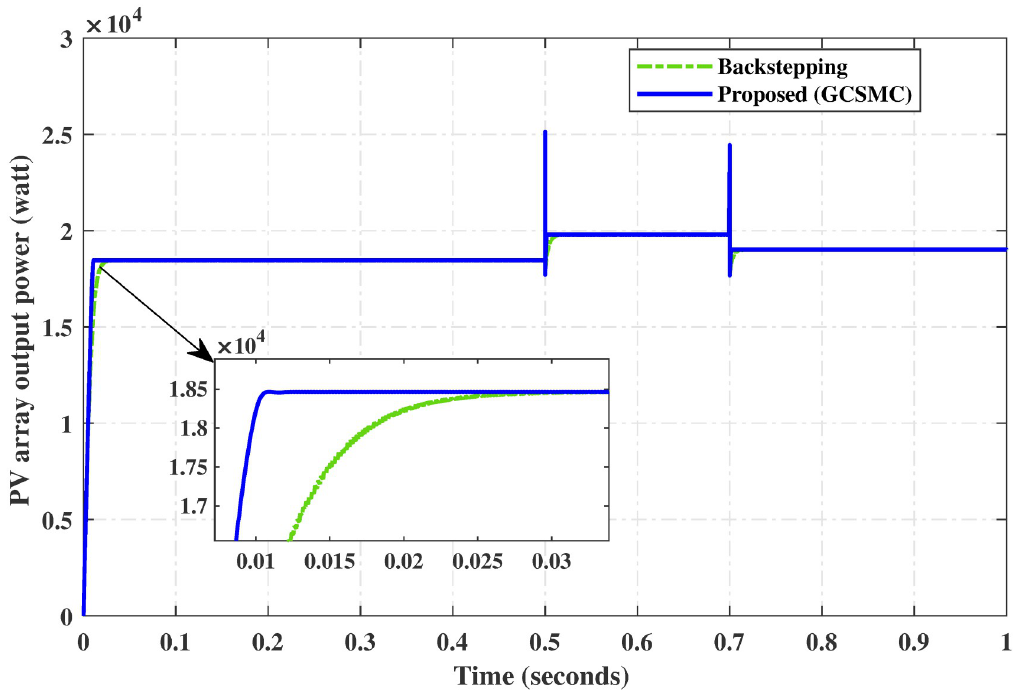
Fig 22. Comparison of PV array voltage under simultaneous variation in temperature and